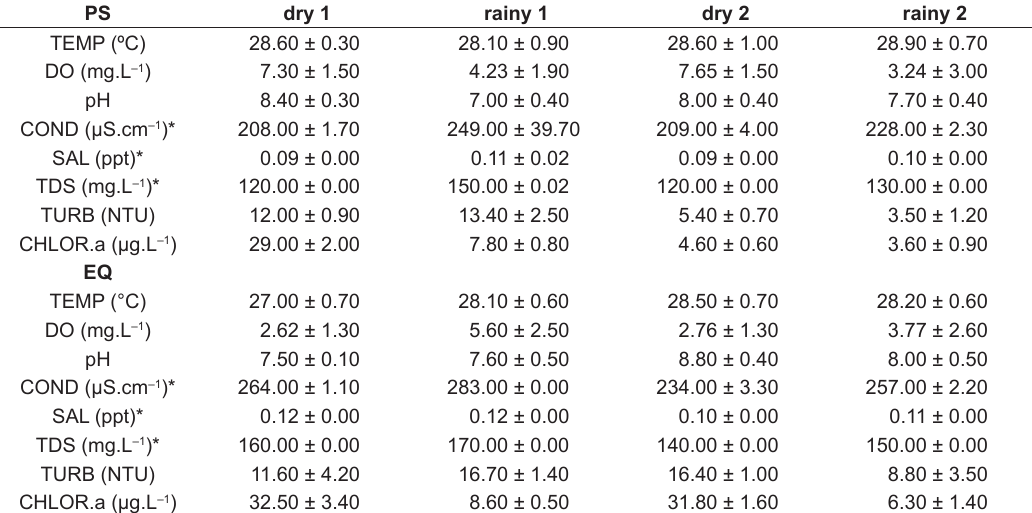
Figure 3. Principal Components Analysis using limnological variables for the Paulo Sarasate (PS) and Edson Queiroz (EQ) reservoirs: (a) differences between reservoirs, (b) temporal variation in reservoirs. TEMP: temperature, DO: dissolved oxygen, pH: hydrogen potential, COND: conductivity, SAL: salinity, TDS: total dissolved solids, TURB: turbidity, CHLOR.a: chlorophyll- a . Table 1. Average values and standard deviations of the physical and chemical properties of water collected in the Paulo Sarasate reservoir (PS) and the Edson Queiroz reservoir (EQ). TEMP: temperature, DO: dissolved oxygen, pH, COND: conductivity, SAL: salinity, TDS: total dissolved solids, TURB: turbidity, CHLOR.a: chlorophyll- a